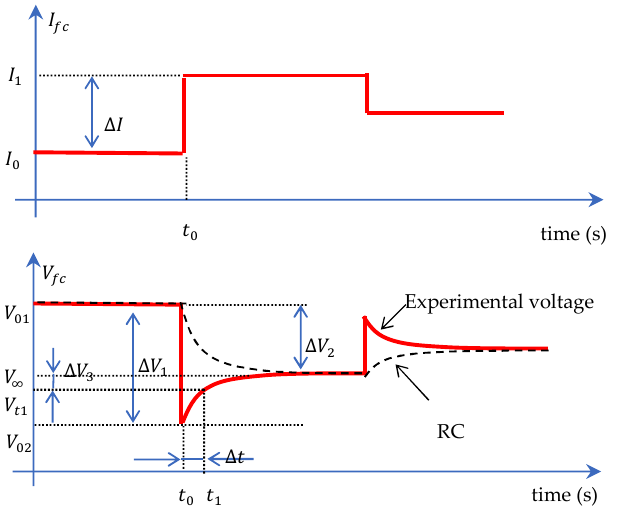
Figure 5. Comparison between the shape of the experimental FC voltage with the equivalent RC circuit.